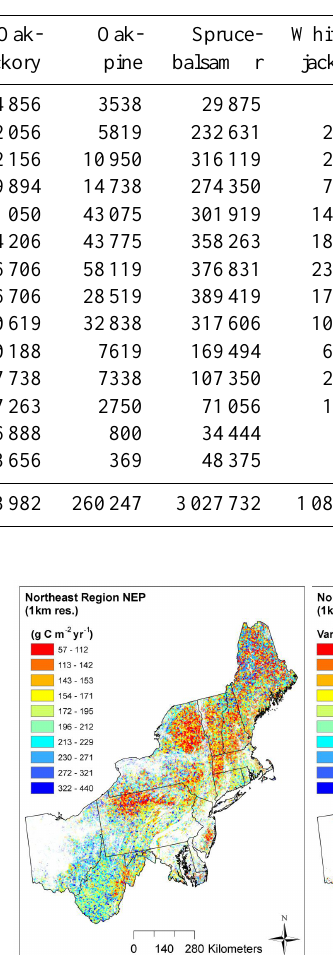
Table 2. Area (ha) by forest type and age class for the Northeast US.